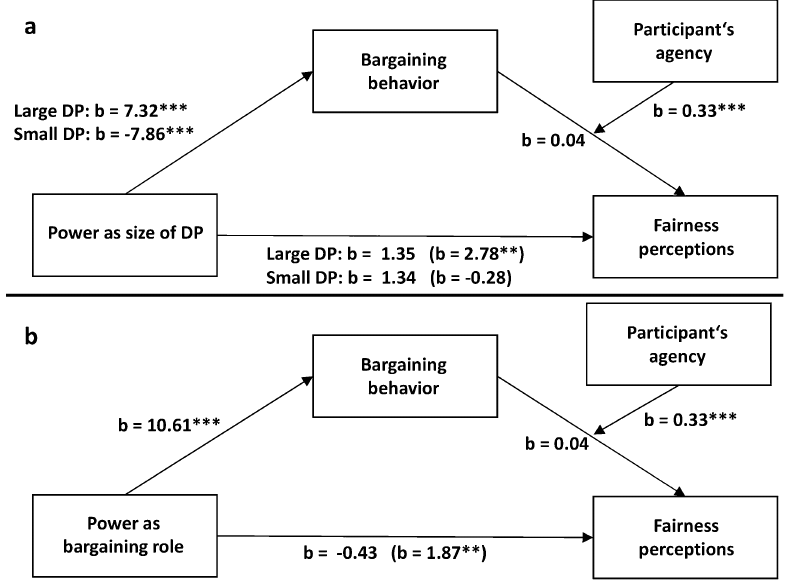
Figure 5. Moderated mediation analyses. Regression coefficients for the relationship between the size of DP ( a ) or bargaining role ( b ) and fairness perceptions as mediated by bargaining behavior and participants’ agency moderating the relationship between bargaining behavior and fairness perceptions. The effects of the size of DP and bargaining role on fairness perceptions controlling for bargaining behavior are in parentheses. Significant relationships between variables are represented by asterisks: *** p < 0.001, ** p < 0.01, * p <